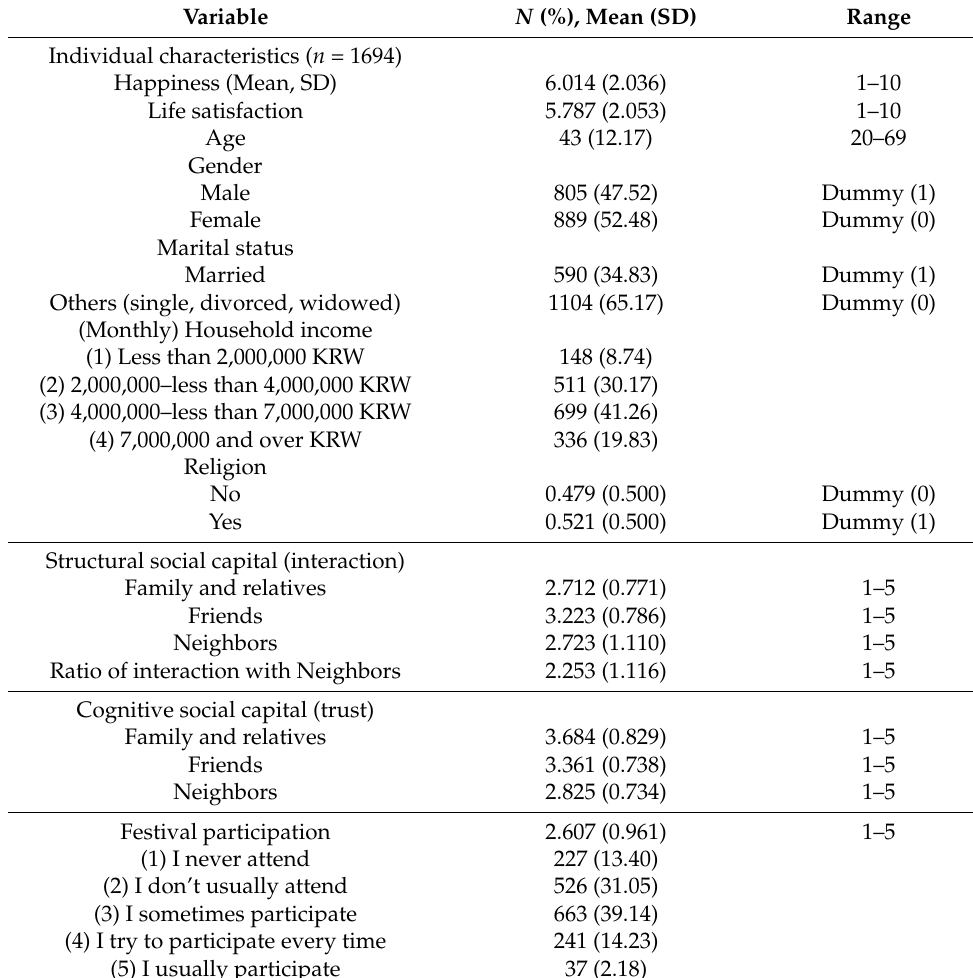
Table 1. Descriptive statistics for the final